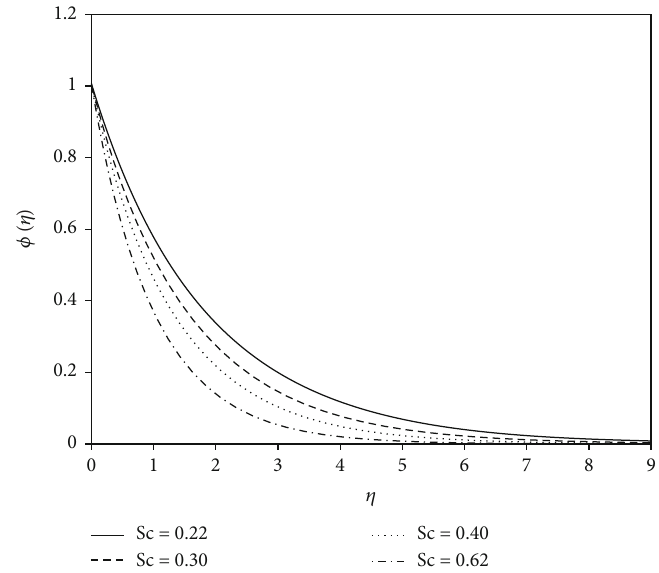
Figure 5: Di ff erent values of Schmidt number S